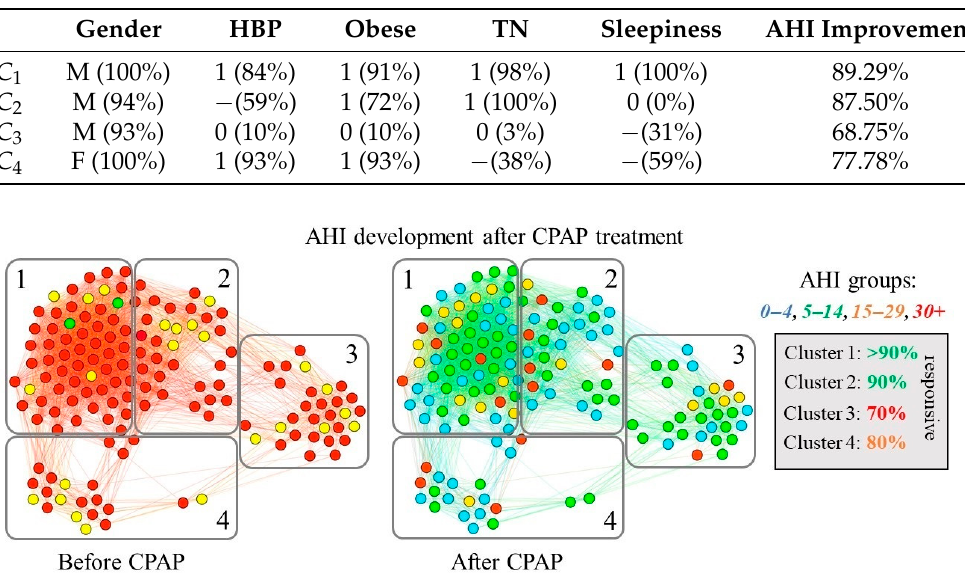
Table 3. Patient input parameter distribution for each community C 1 − C 4 . A value of 1 means that the parameter class is representative for the community, 0 means the inverse class is representative (e.g., HBP vs. LBP), and “-” means that none of the parameter classes is representative. The apnea– hypopnea index (AHI) improvement quantifies the percentage of patients who have reduced their OSA severity from sev to mild or norm after CPAP treatment.